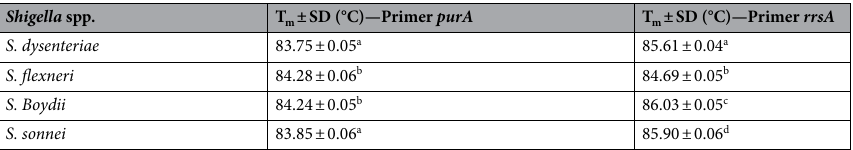
Table 2. Melting temperatures in PCR-HRM assay of the control strains of Shigella species. SD Standard deviation, T m Melting temperature. Different letters in each column showed significant differences ( P < 0.01).